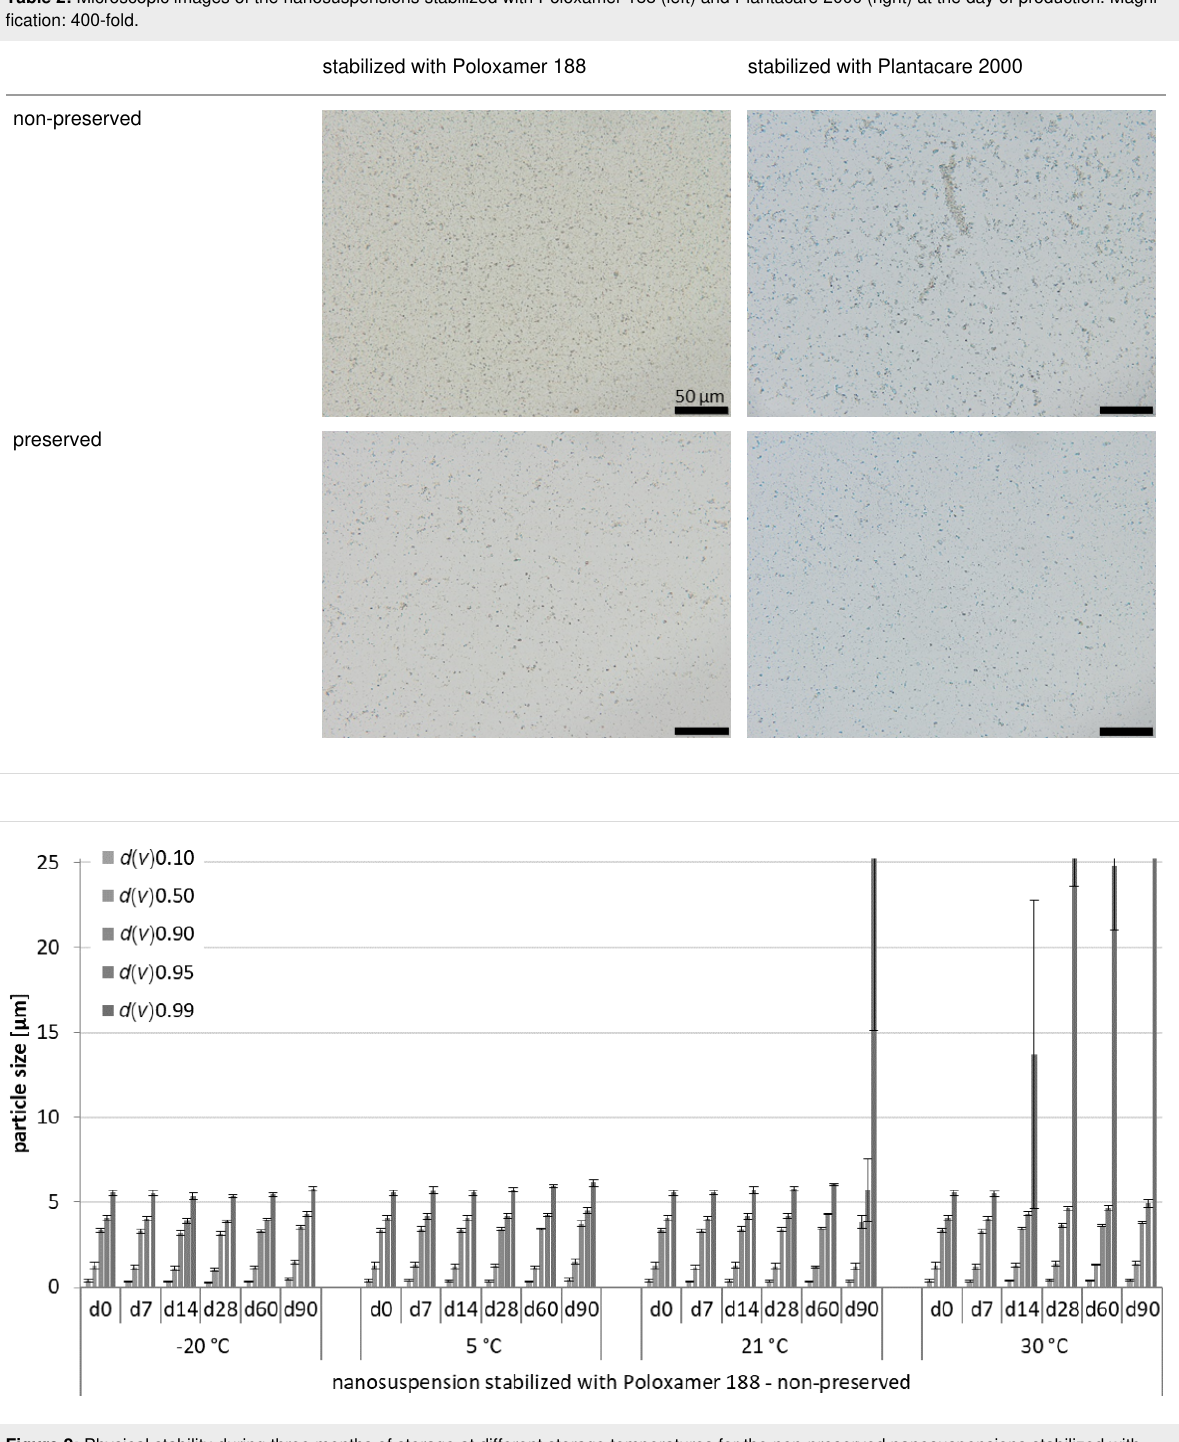
ture might change the interaction between preservative and par- ticles and thus the stability. More research is needed to under- stand these phenomena in